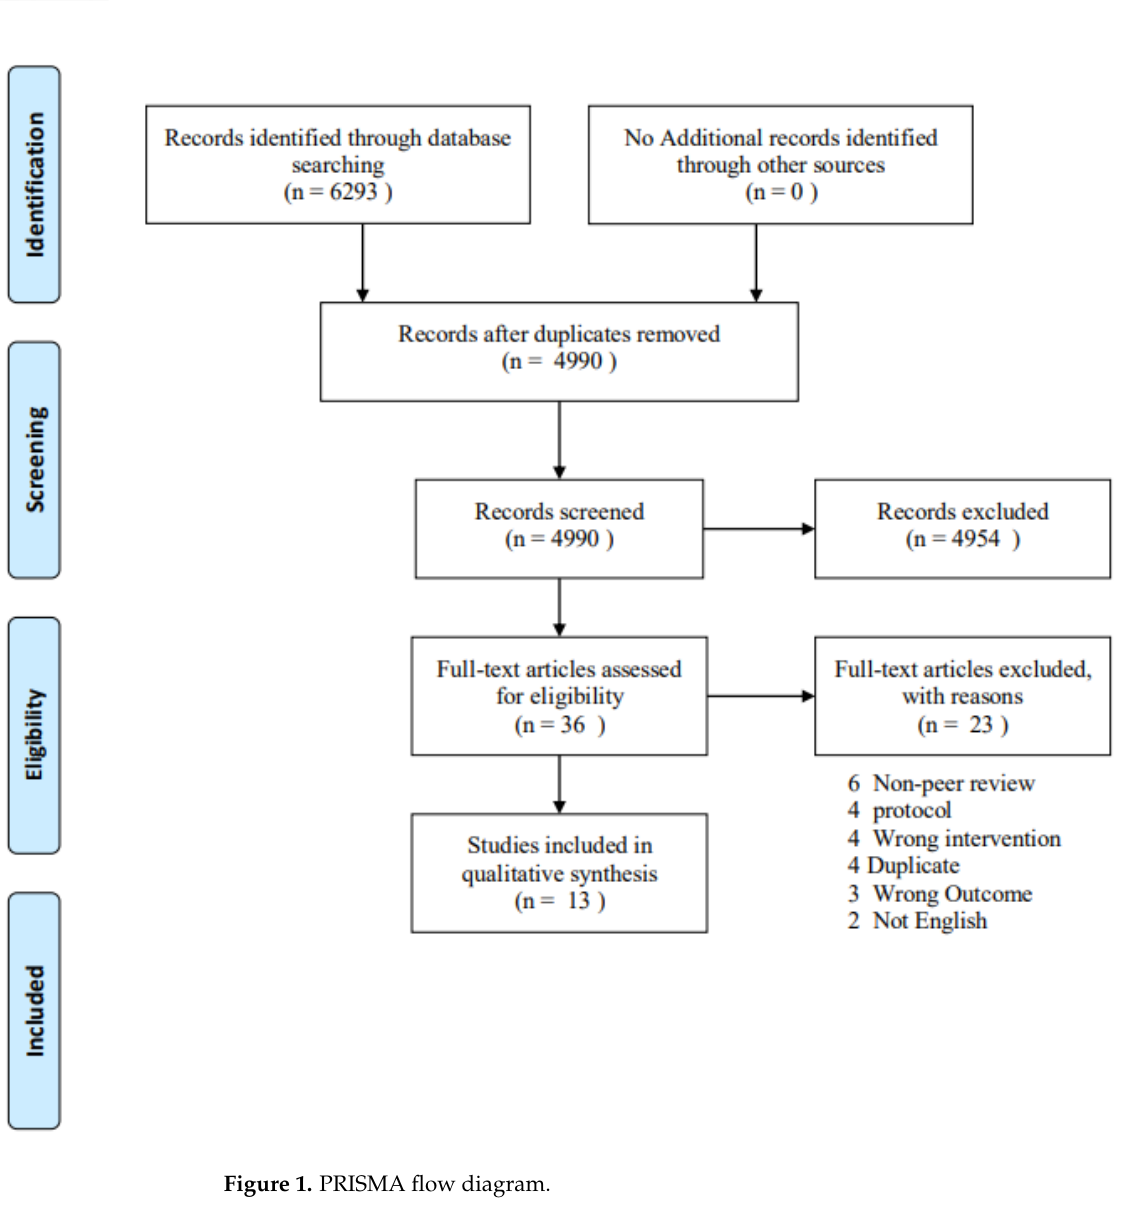
Figure 1. PRISMA flow diagram.